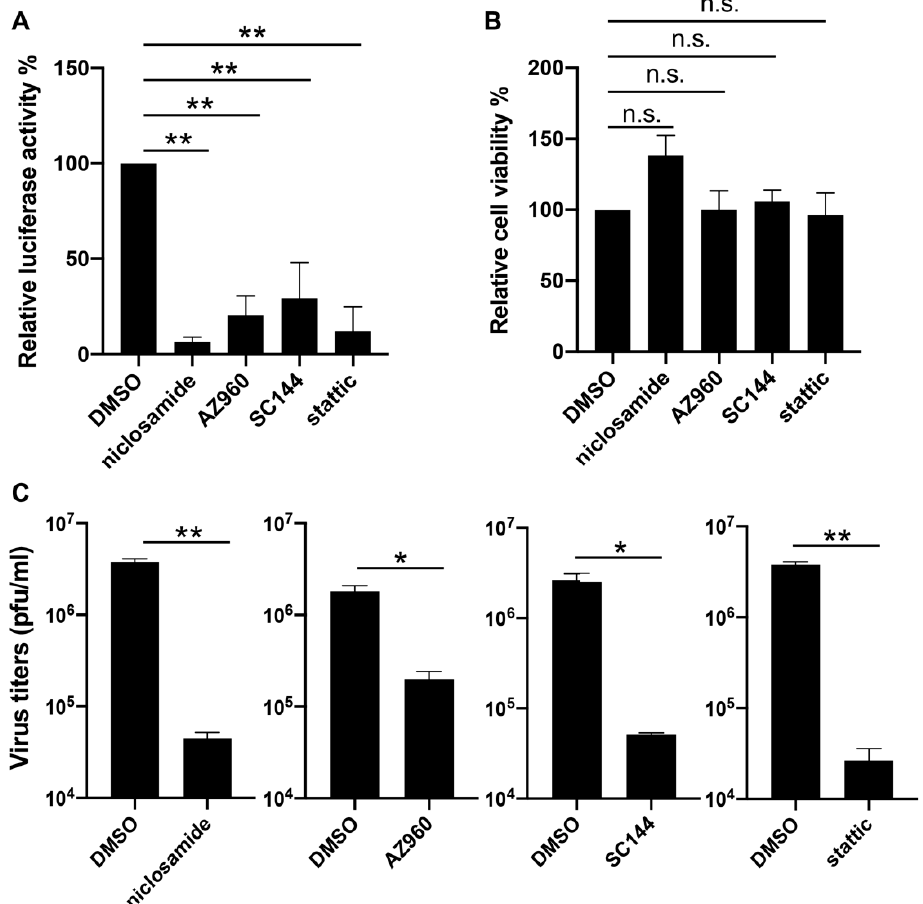
Figure 3. Inhibition of VACV by STAT3 inhibitors. ( A ) Normal human dermal fibroblast (NHDF) cells were treated with DMSO, niclosamide (1 µ M), AZ960 (3 µ M), SC144 (1 µ M), or static (3 µ M), and then they were infected with vLGluc at 1 PFU / cell. At 8 h later, luciferase activity was determined in collected cell culture media. ( B ) NHDF cells were treated with the above drugs for 24 h and cell viability was measured by an MTT (3-(4,5-dimethylthiazol-2-yl)-2,5 diphenyl tetrazolium bromide) assay. Three biological replicates were carried out. Error bars indicated standard deviation. ( C ) NHDF cells were treated with selected STAT3 inhibitors at the concentrations mentioned above and infected with VACV-WR at 0.01 PFU / cell. Viruses were collected at 48 hpi and tittered in BS-C-1 cells. Error bars indicate standard deviation (n = 3). Statistics: * p < 0.05, ** p < 0.01, n.s.: non-significant by two- sided Students’ T test.